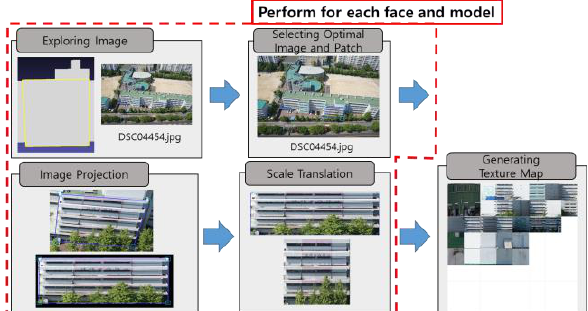
Figure 11. Process of texturing by